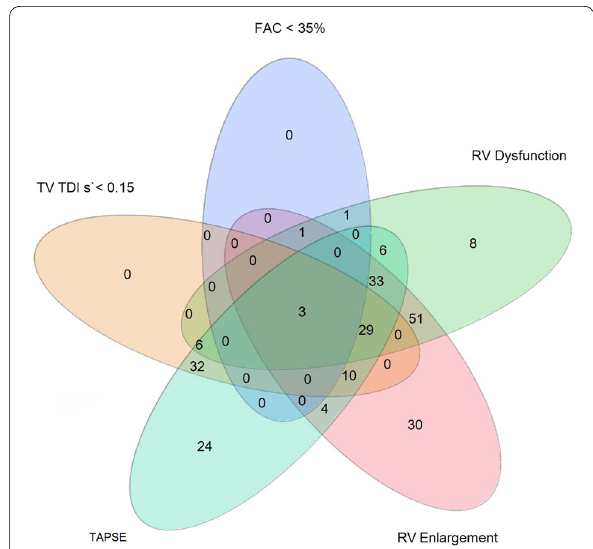
Fig. 2 Right ventricular dysfunction using multimodality parameters. Abbreviations : FAC fractional area change, RV right ventricular, s ′ systolic velocity, TAPSE tricuspid annular plane systolic excursion, TDI tissue Doppler imaging, TV tricuspid